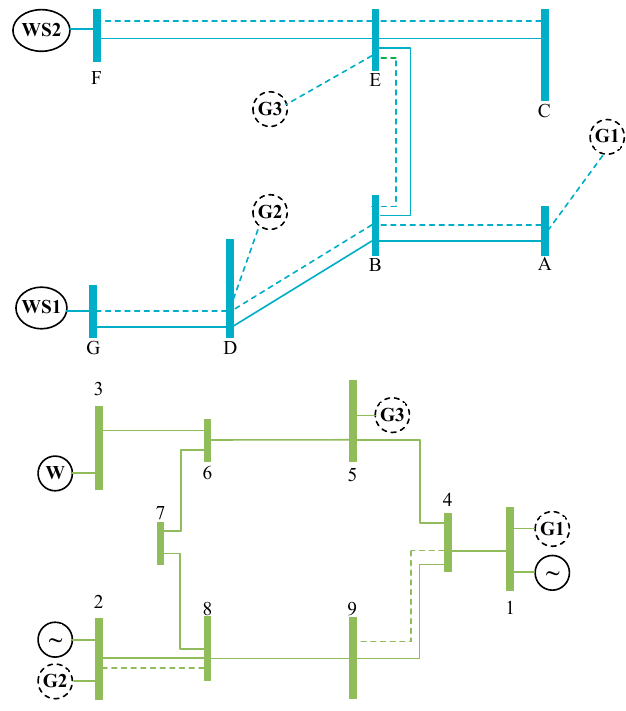
Figure 3. Planning grid under scenario 1.